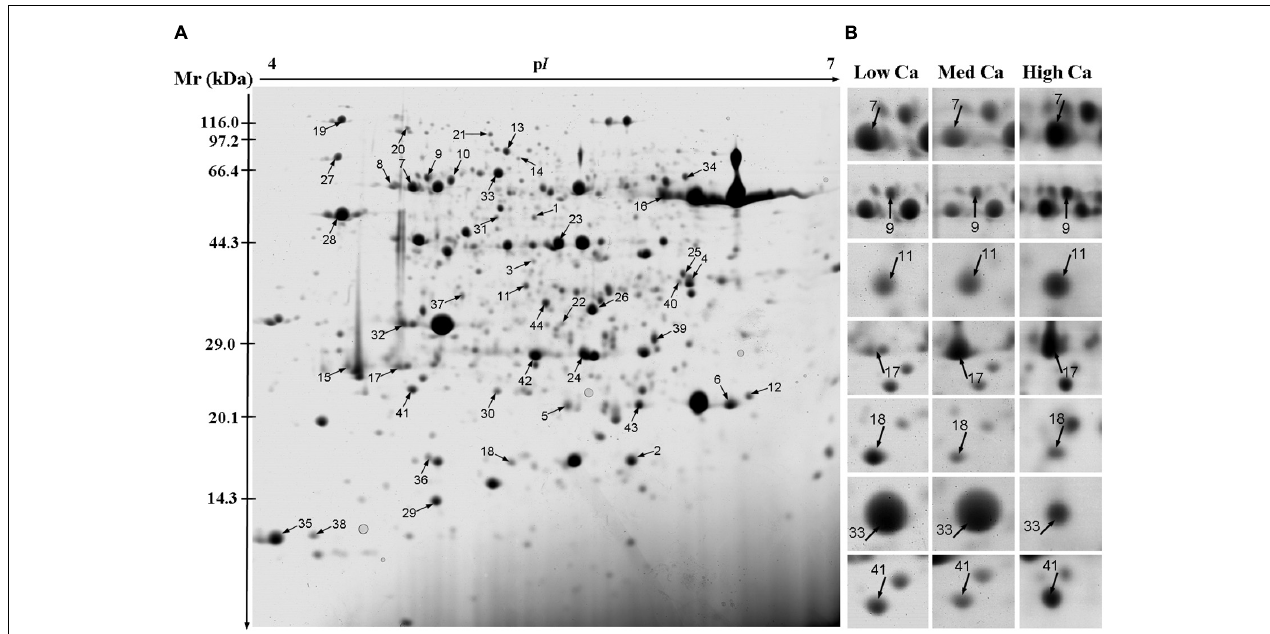
FIGURE 3 | Two-dimensional electrophoresis analysis of proteins extracted from the leaves of T. wallichiana var. mairei treated at different Ca levels under AR stress. The numbers are assigned to the protein spots correspond to those listed in Table 1 . (A) Representative CBB R250-stained 2D gel of total proteins. Arrows indicate 44 spots showing at least twofold changes ( p < 0.05) analyzed by MALDI-TOF/TOF MS. (B) The enlarged window represents some differentially expressed protein spots after AR treatment at different Ca